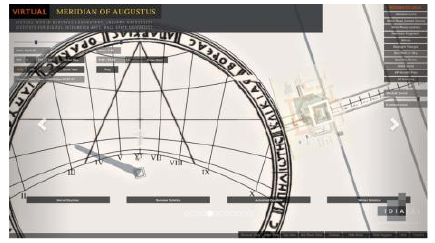
winter months from October 30th to February 11th.